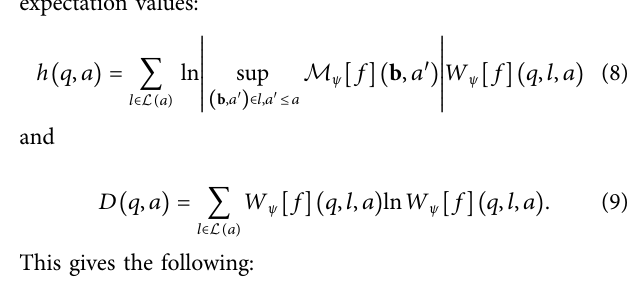
Frontiers in Physiology |